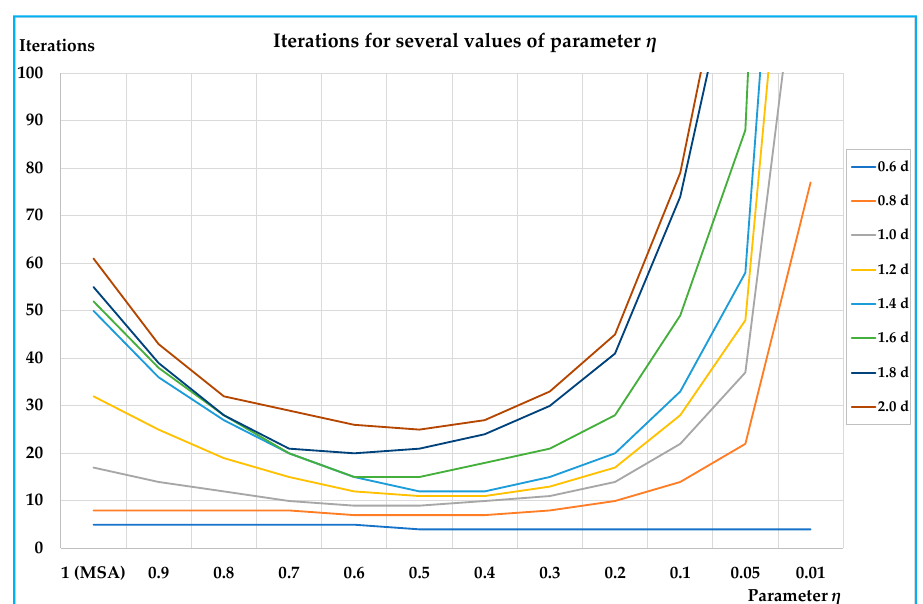
Figure 5. Results on the urban real-scale network ( C v = 0.10). Table 7. Results on the urban real-scale network ( C v = 0.05).